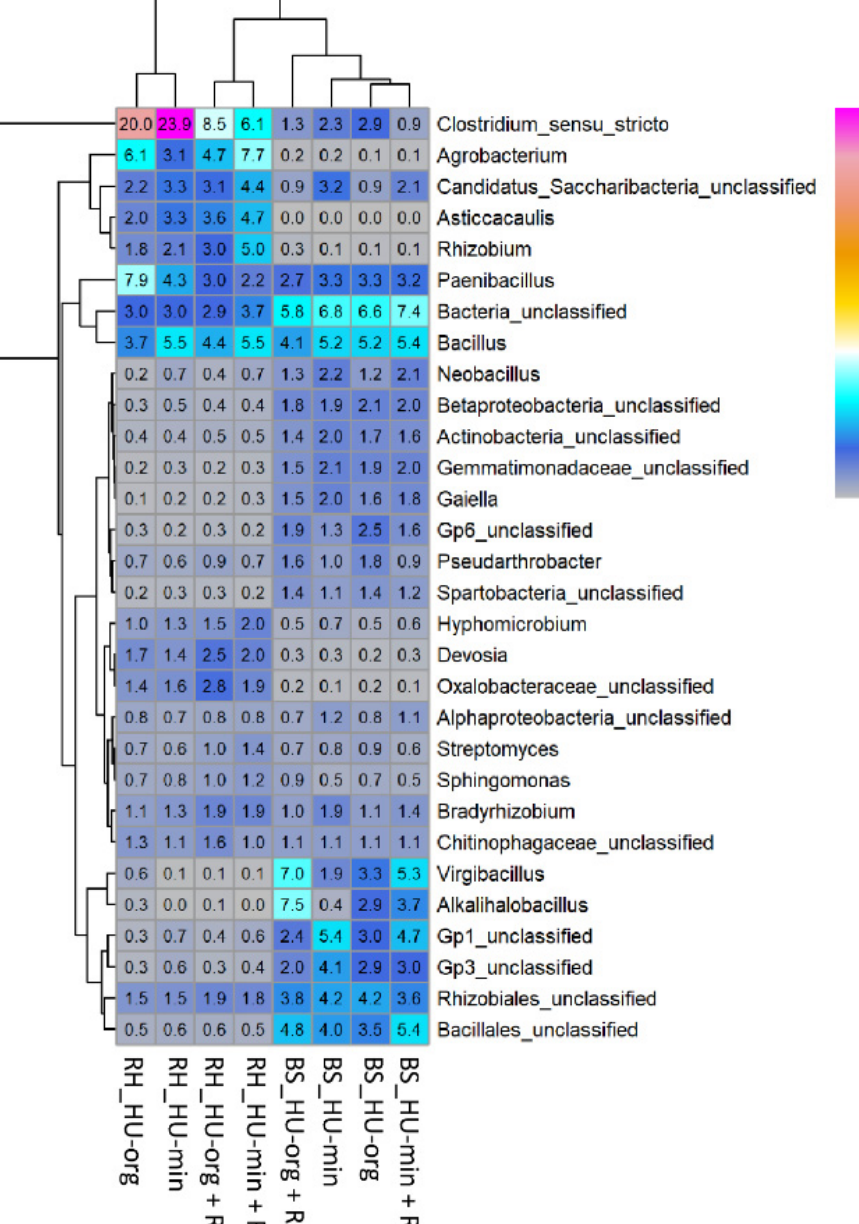
Figure 4. Relative abundance of the 30 major bacterial genera in bulk soil (BS) and rhizosphere (RH) of lettuce (cv. Tizian) grown in soils with organic (HU-org) or mineral (HU-min) fertilization history in the absence and in the presence of Rhizoctonia solani AG1-IB